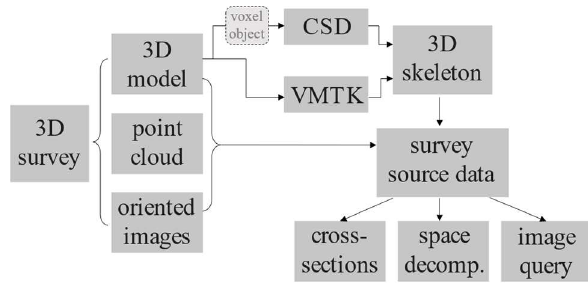
Figure 6. Workflow of the proposed